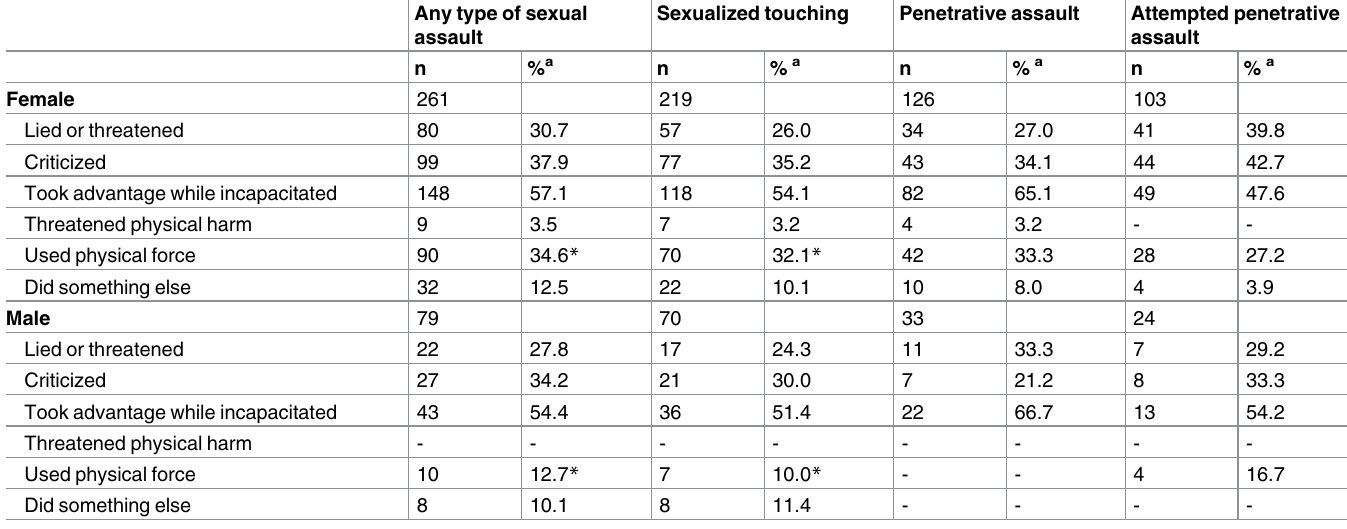
Table 3. Methods of perpetration used in sexual assaults since enrolling at CU/BC, by type and